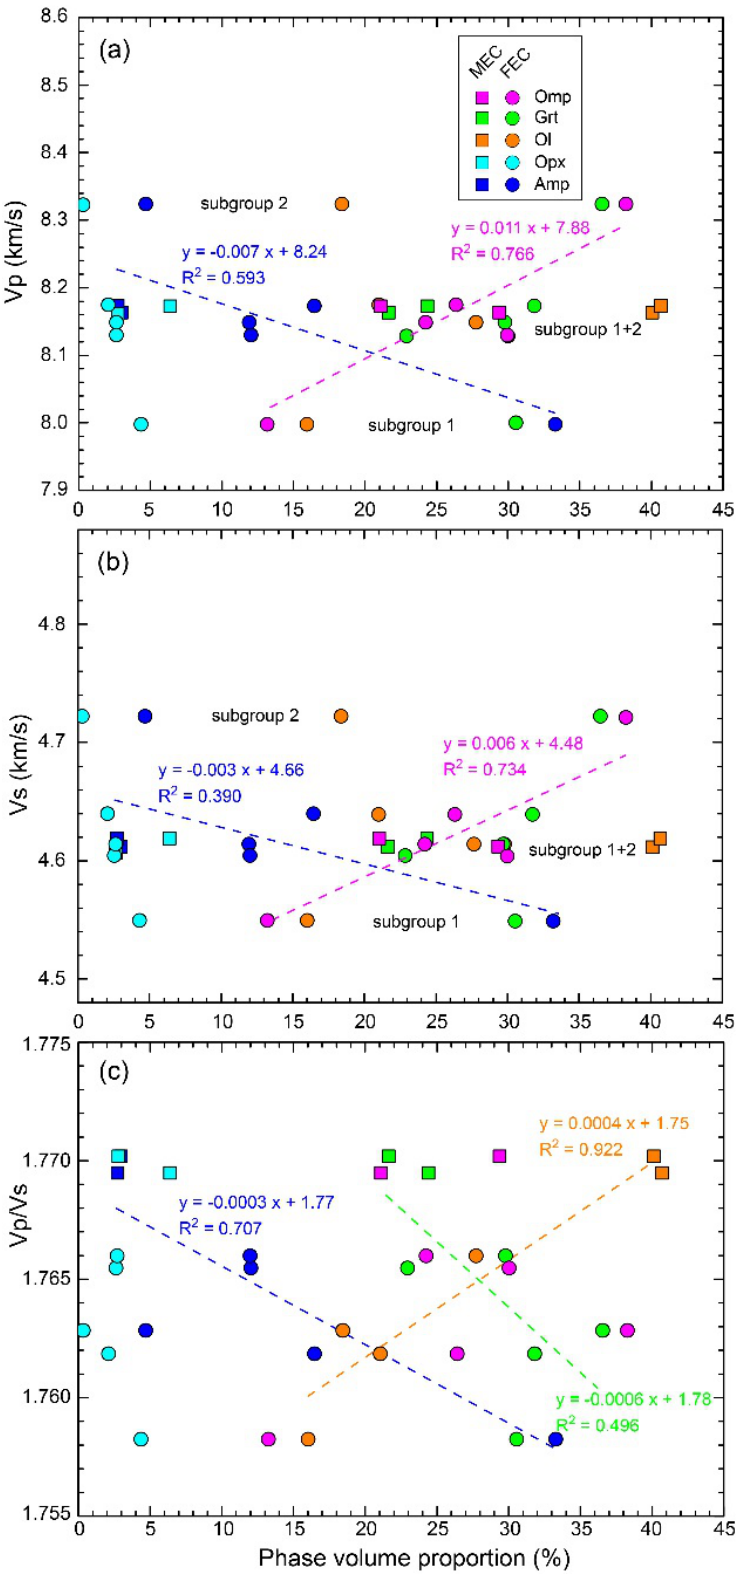
Figure 11. Relations between the phase volume proportions and the bulk rock ( a ) Vp, ( b ) Vs, and ( c ) Vp/Vs ratio in the MEC and FEC. The blue, magenta, orange, and green dashed lines are the best-fitting curves, along with their fitting functions, for Amp, Omp, Ol, and Grt, respectively.